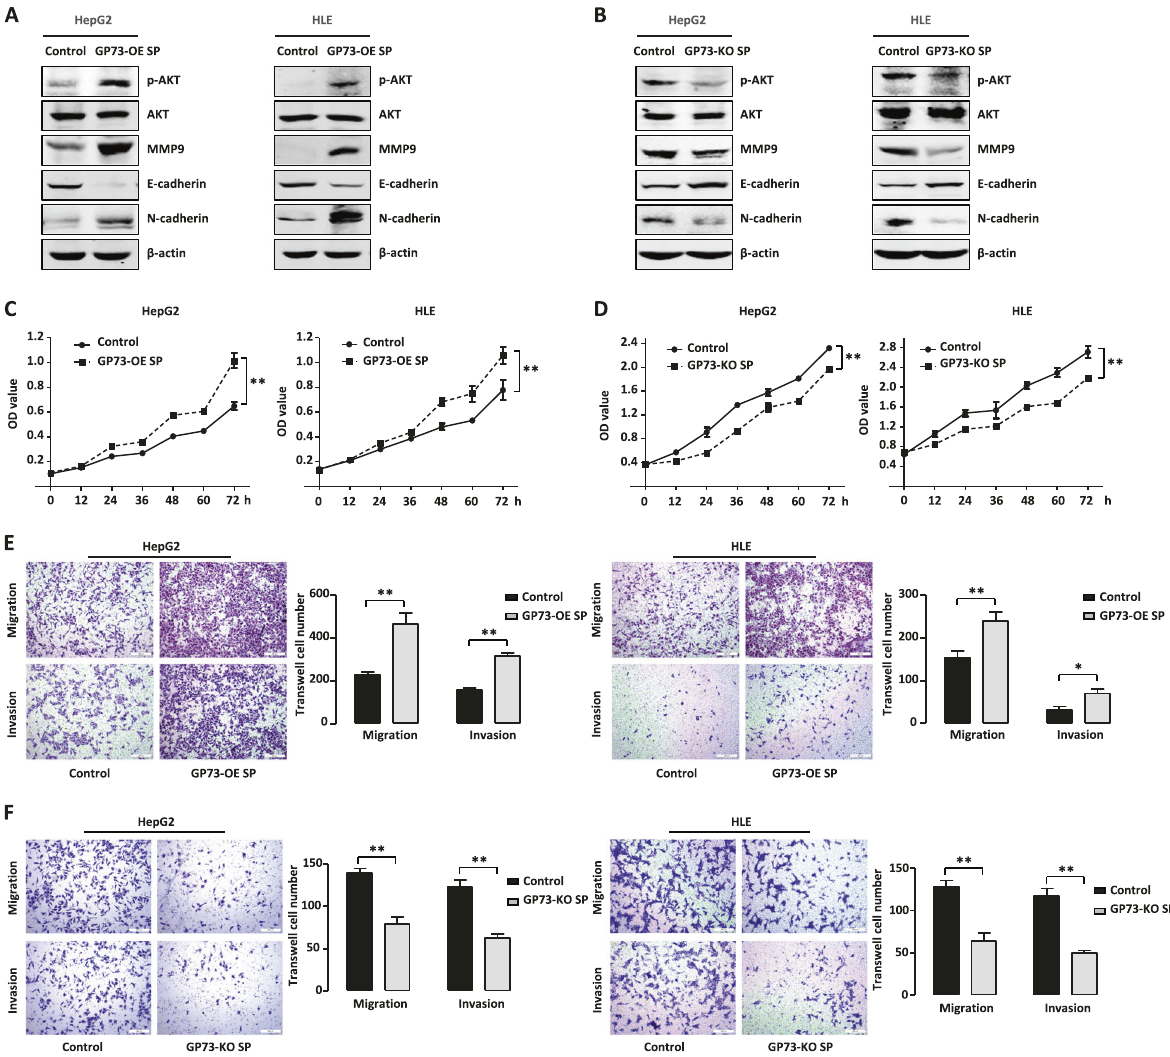
Fig. 4 GP73-mediated secretion promotes proliferation and metastasis of HCC cells. A , B GP73-mediated secretion in fl uences the expression of proliferation and metastasis-related proteins. A HepG2 and HLE cells treated with or without GP73 overexpression supernatant (GP73-OE SP) were analyzed by western blotting. B HepG2 and HLE cells treated with or without GP73 knockout supernatant (GP73-KO SP) were analyzed by western blotting. β -actin was used as a loading control. C , E GP73-OE SP treatment promotes proliferation, migration, and invasion of HCC cells. MTT assay ( C ) and Transwell assay ( E ) were conducted with HepG2 and HLE cells treated with or without GP73-OE SP. Scale bar, 200 μ m. D , F GP73-KO SP treatment inhibits proliferation, migration and invasion of HCC cells. MTT assay ( D ) and Transwell assay ( F ) were conducted with HepG2 and HLE cells treated with or without GP73-KO SP. Scale bar, 200 μ m. Error bars represent S.D. * p < 0.05, ** p <